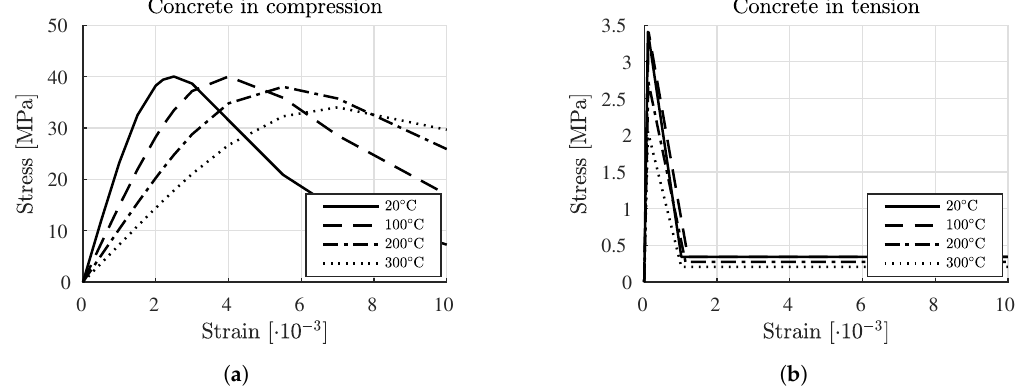
Figure 17. Temperature-dependent stress-strain relations recommended by Eurocode 2 for concrete subjected to uniaxial ( a ) compression and ( b )